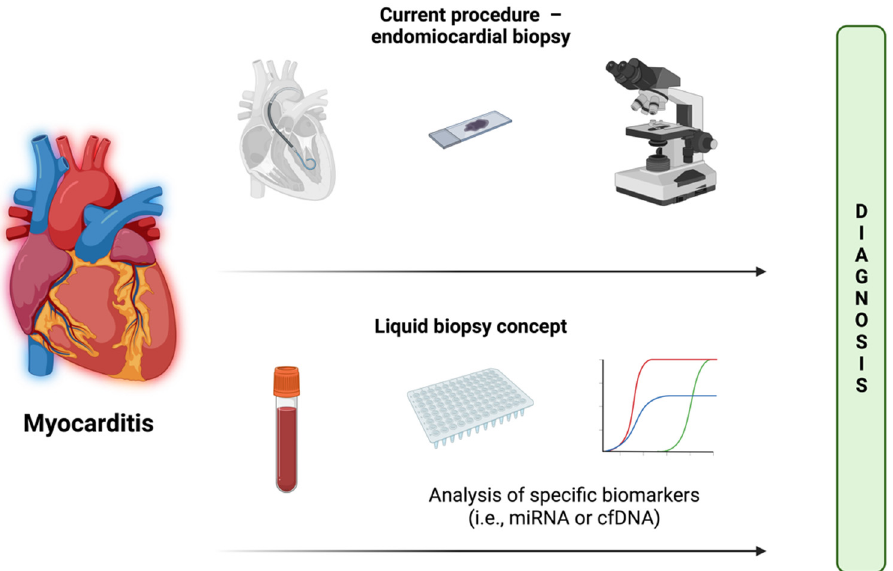
Figure 1. Concept of liquid biopsy. In comparison to endomyocardial biopsy, it requires only a blood sample. The goal is to achieve comparable diagnosis accuracy. Created with BioRender.com. Accessed on 7 September 2022.